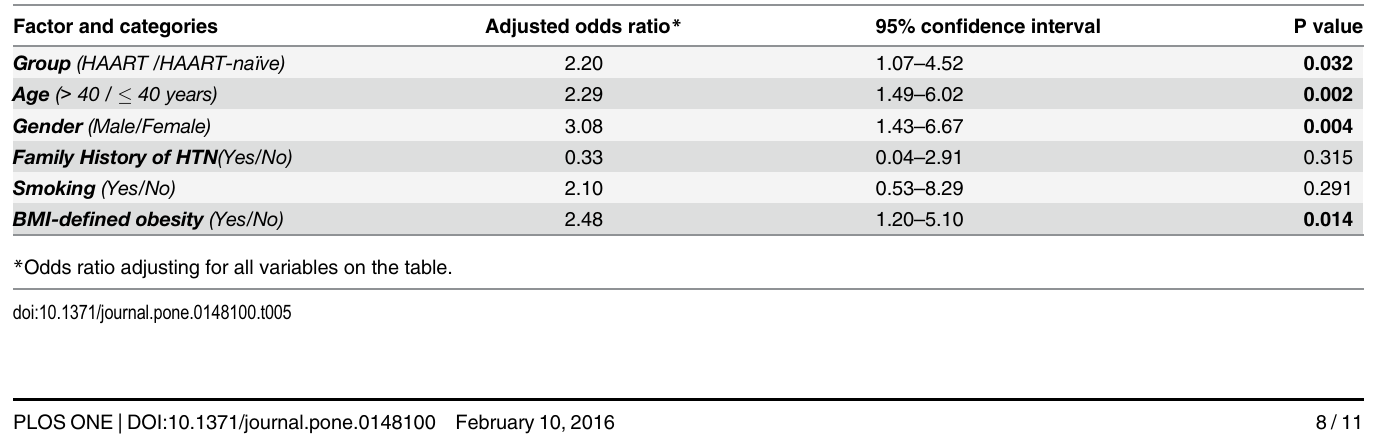
Table 5. Association between HAART and hypertension after controlling for